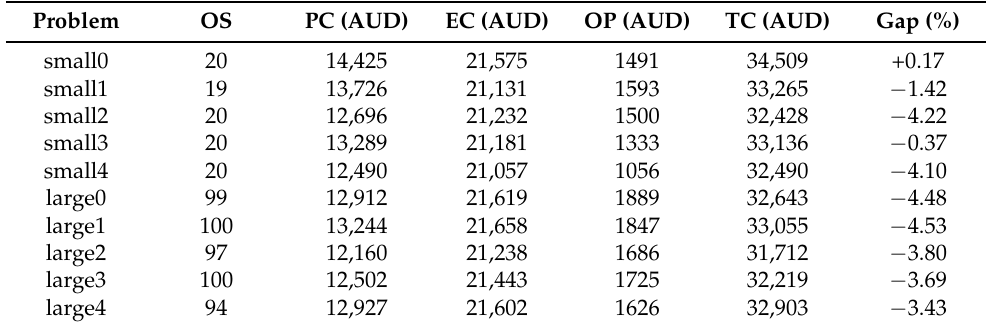
Table 8. Detailed results of the winning approach on all ten problem instances and percentage gaps of total costs as compared to our approach.